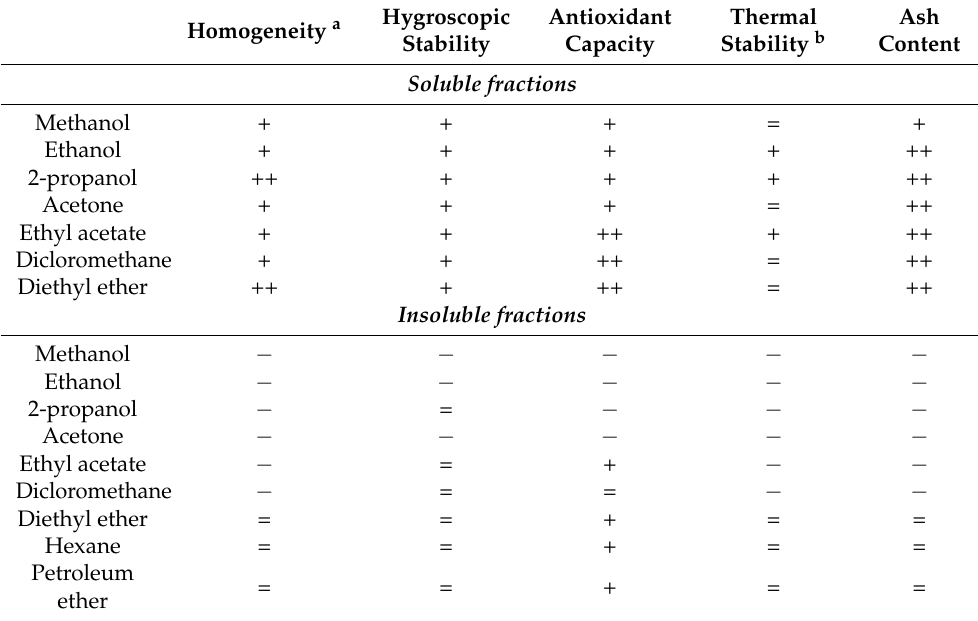
Table 6. Summary table of all tests performed on lignin fractions. Homogeneity a